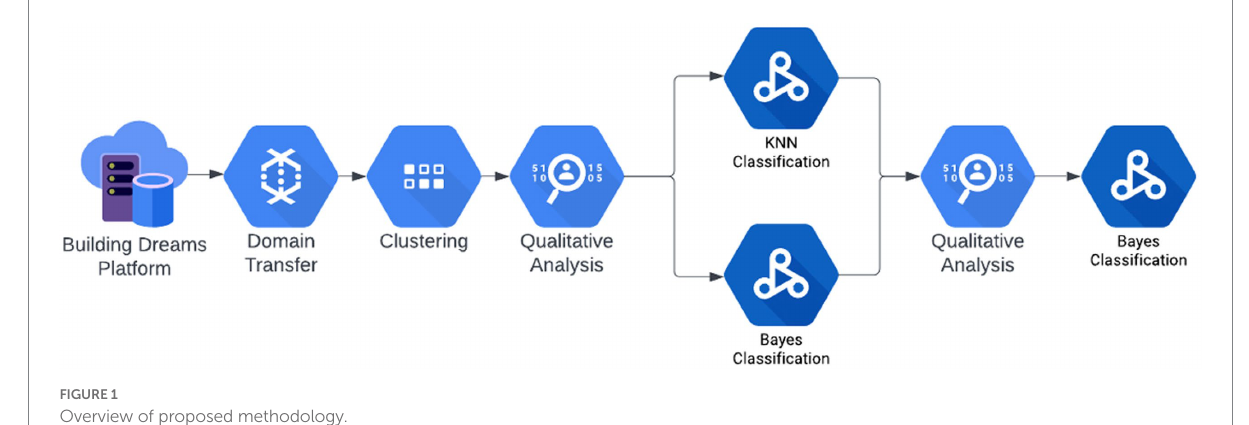
FIGURE 1 Overview of proposed